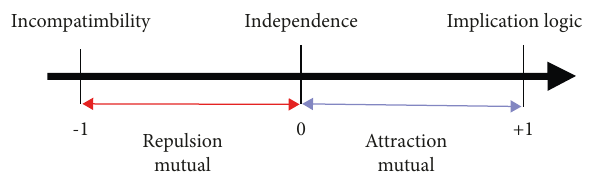
Figure 1: Distribution of continuous normalised MPQ values mutual repulsion and mutual